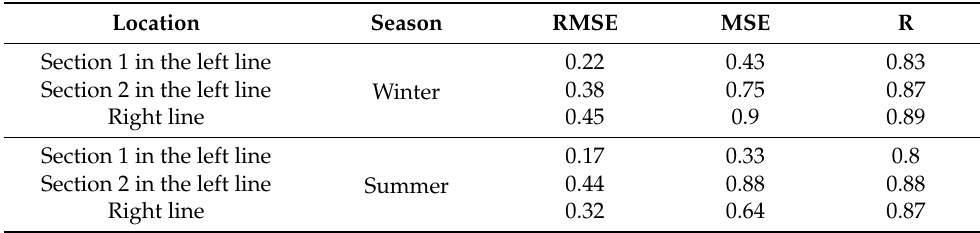
Figure 10. Comparison between the predicted and measured natural wind speed. The error between the predicted and the measured value is shown in Table 8. Table 8. Error of each tunnel section.